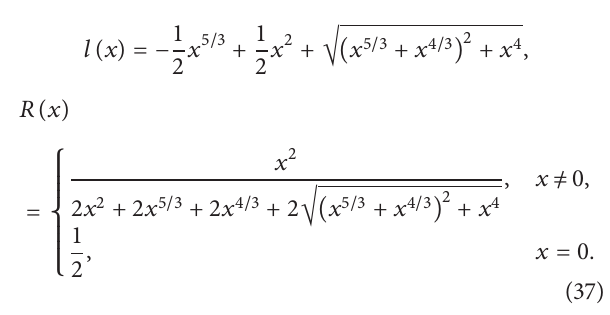
is finite time stable in probability. And the control law (36) minimizes the cost functional (14)